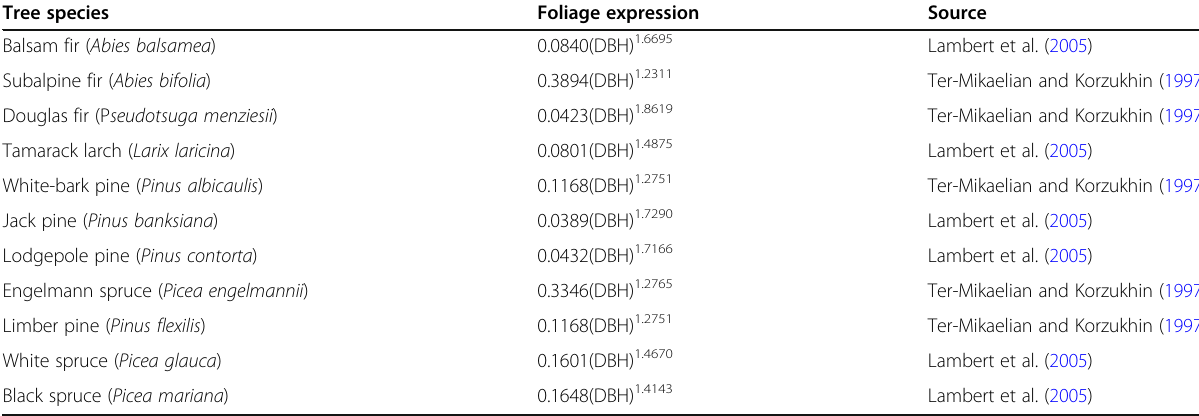
Table 1 Allometric equation used to estimate the crown fuel (kg) of a tree using its diameter at breast height (DBH, cm) for all conifer species present in the data Tree